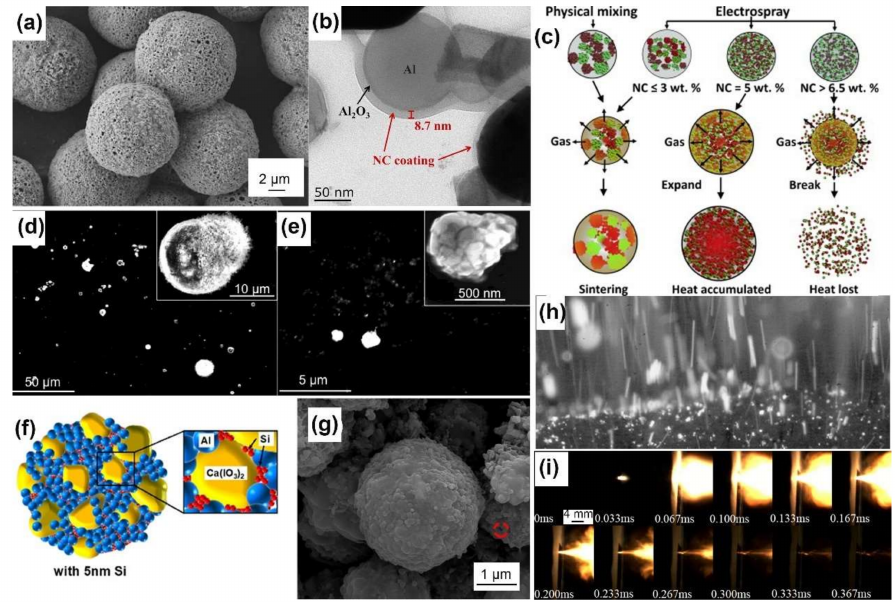
Figure 3. ( a ) SEM image of Al/CL-20 (30 wt%)/NC (2.5 wt%) microspheres prepared by electrospray.